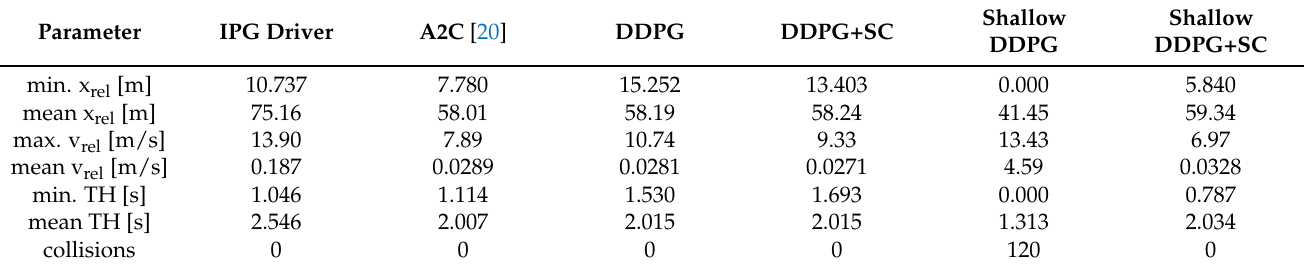
Table 2. 10-hour driving test under naturalistic driving conditions in IPG